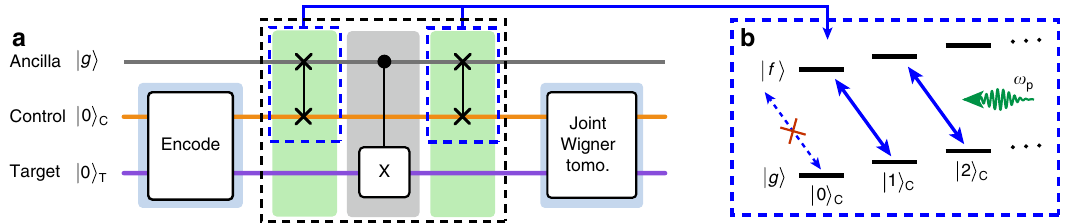
Fig. 2 Protocol of the entangling gate. a The sequence starts with preparation of the desired initial two-cavity state, while leaving the ancilla transmon in the ground state. The cavity – cavity CNOT gate (dashed black rectangle) consists of two entangling gates between the control cavity and the ancilla (dashed blue rectangles), interleaved by a CNOT gate between the ancilla and the target, implemented by a conditional π /2 phase-space rotation of the target cavity. The joint Wigner distribution of the fi nal two-cavity state is measured using a method similar to ref. 20 . b Schematic level diagram illustrating the RF-driven control-ancilla sideband transition. Through the absorption of a single drive photon (in green) and a single control photon, the ancilla is doubly excited from g j i to f j i (solid blue arrows). However, when the control cavity is in vacuum, the absence of a control photon prevents the ancilla from being excited to f j i (dashed blue arrow)